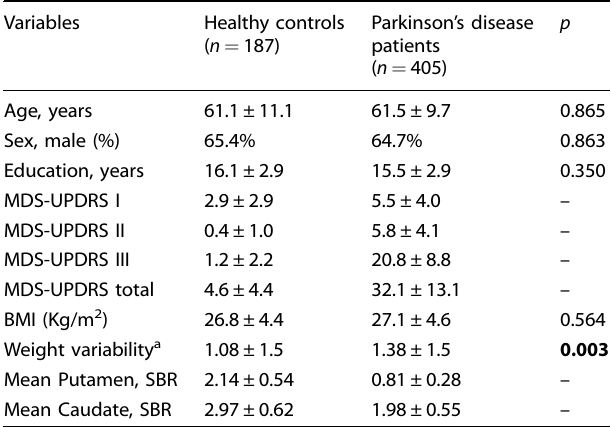
Table 1. Baseline Characteristics of Parkinson's Disease patients and healthy